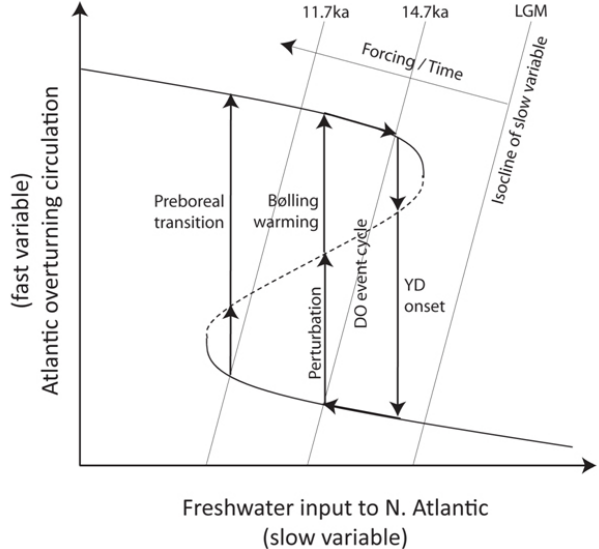
Fig. 1. Simple conceptual model of deglacial climate dynamics in terms of a slow-fast system. This incorporates the hypothesis that during the deglaciation there is a gradual approach toward a bifur- cation in which the cold climate state loses its